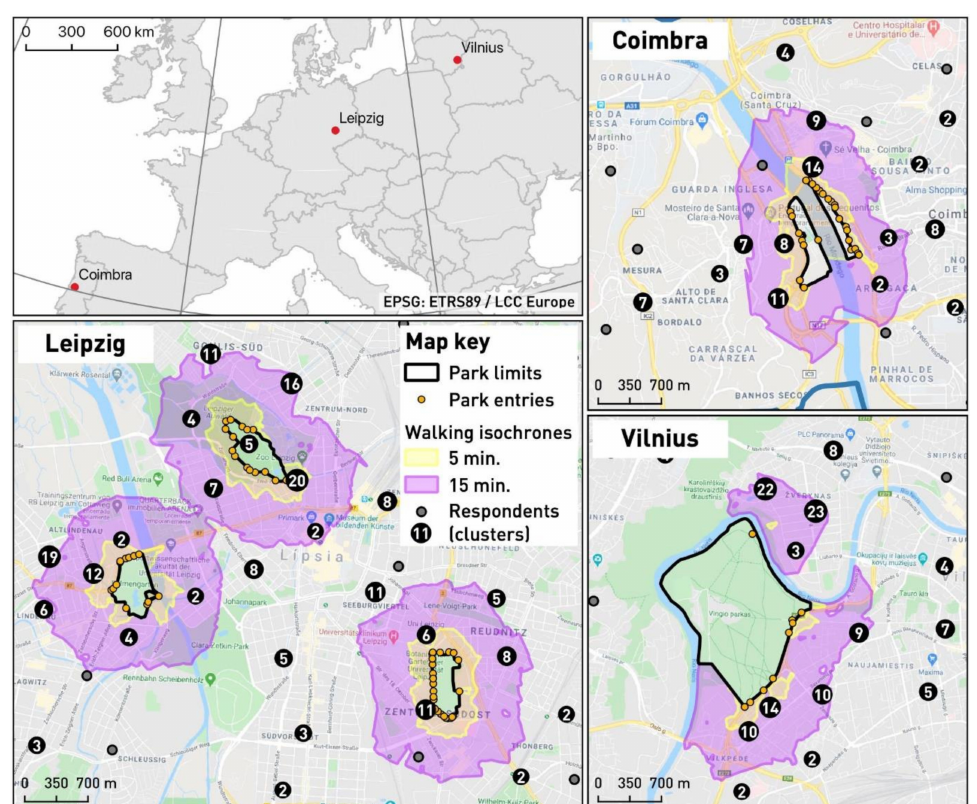
Figure 1. Map of case study sites, with park entrances and 5 min (300 m) and 15 min (900 m) walking distance isochrones (clusters: respondents living in the same neighbourhood; the number indicates the number of